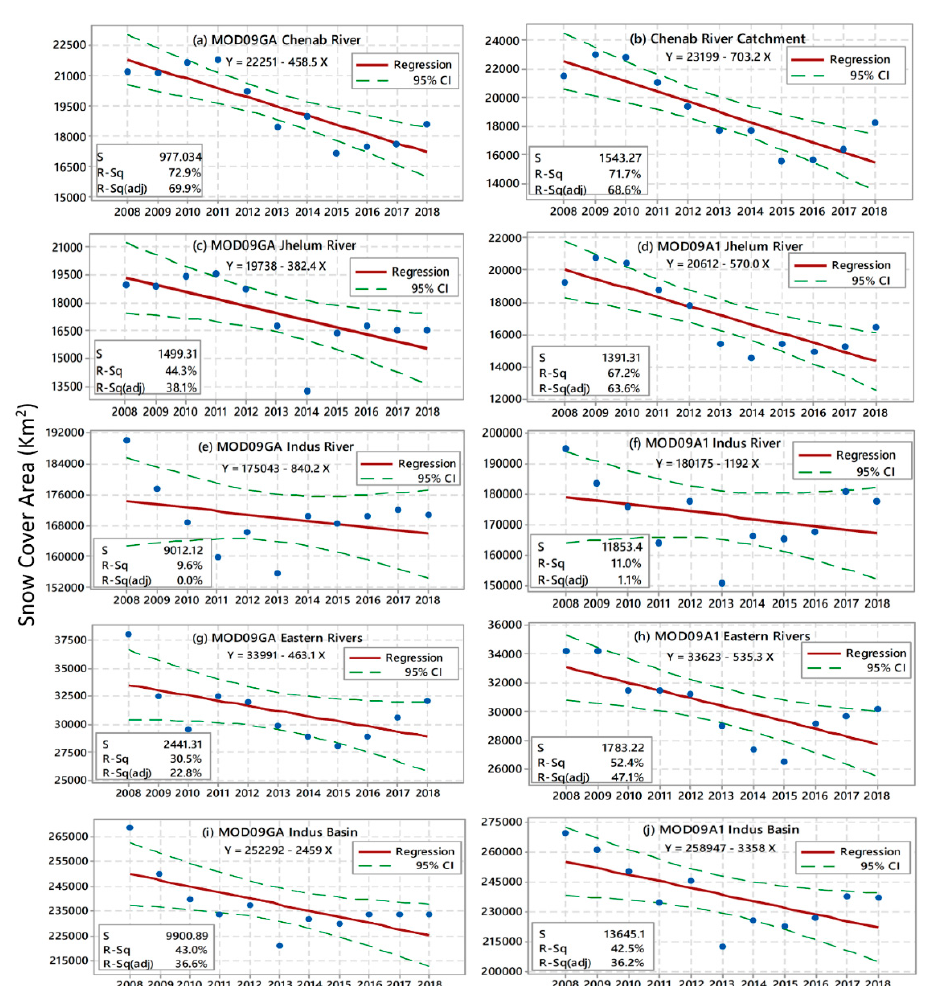
Figure 8. Maximum snow cover trends of MODIS MOD09GA and MOD09A1 products from 2008 to 2018. The catchments represent: ( a , b ) Chenab river, ( c , d ) Jhelum river, ( e , f ) Indus river, ( g , h ) eastern rivers and ( i , j ) Indus basin.